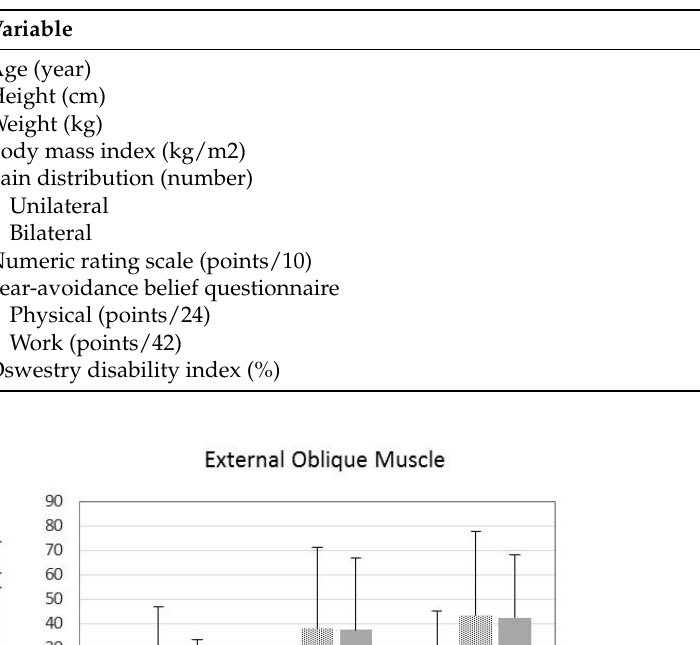
Table 1. Participant baseline characteristics ( n = 30).